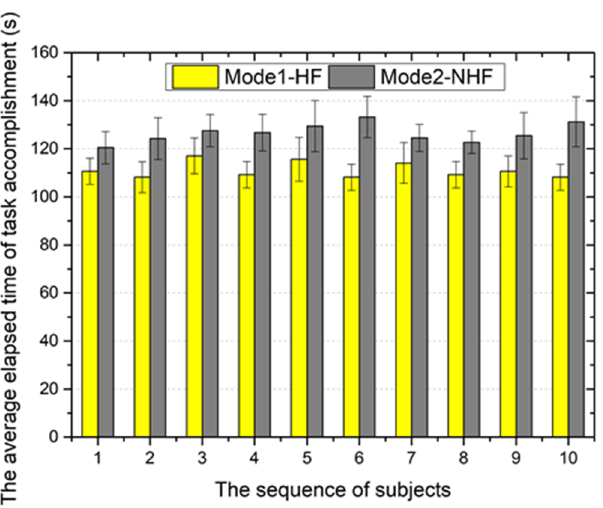
Figure 20. The average maximum force of the task accomplishment.